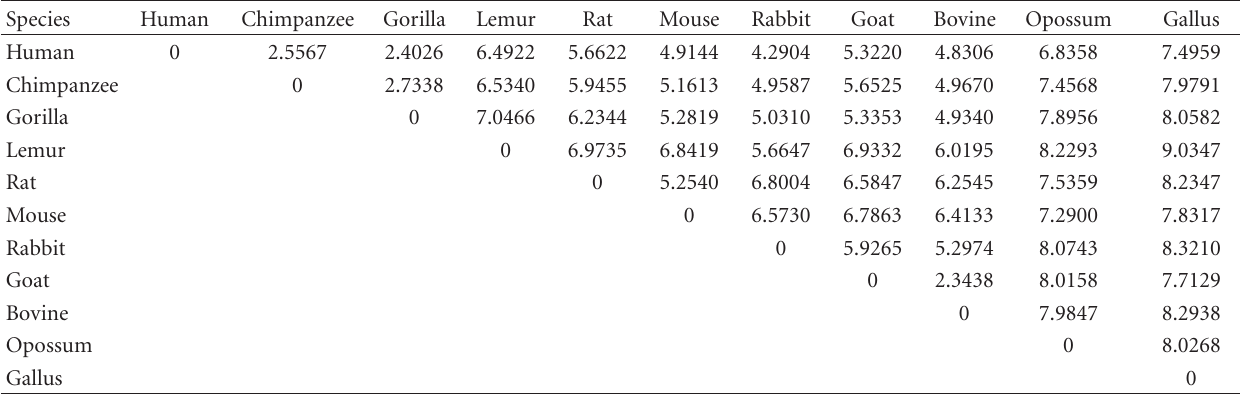
Table 3: The upper triangular part of the dissimilarity/similarity matrix based on d 1 .